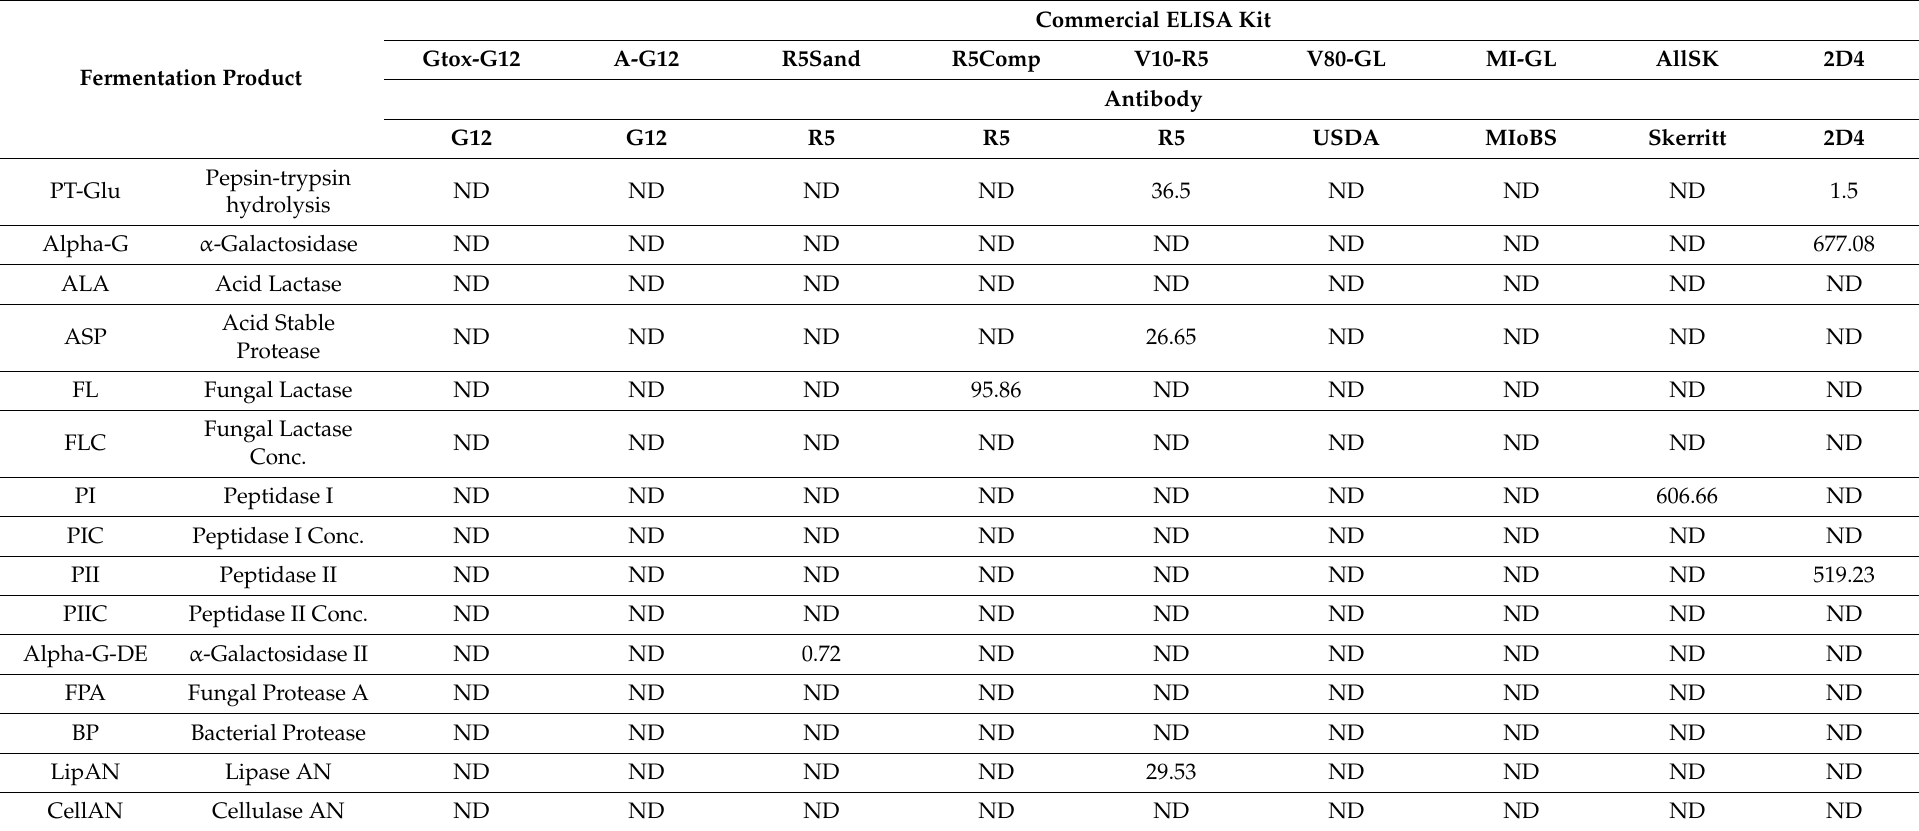
Table 4. Gluten levels for the supplemental enzyme samples were negligible or lower than the PT-digested gluten standard (PT-Glu) for the majority of antibodies, as determined by immunoblotting (N = 6). ND =